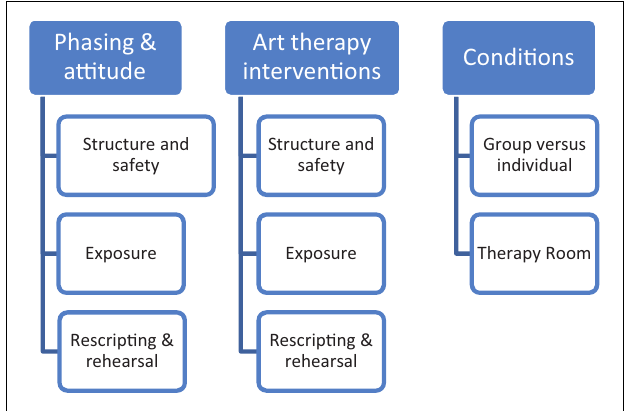
FIGURE 3 | Framework of the basic elements of IRT-based art therapy.